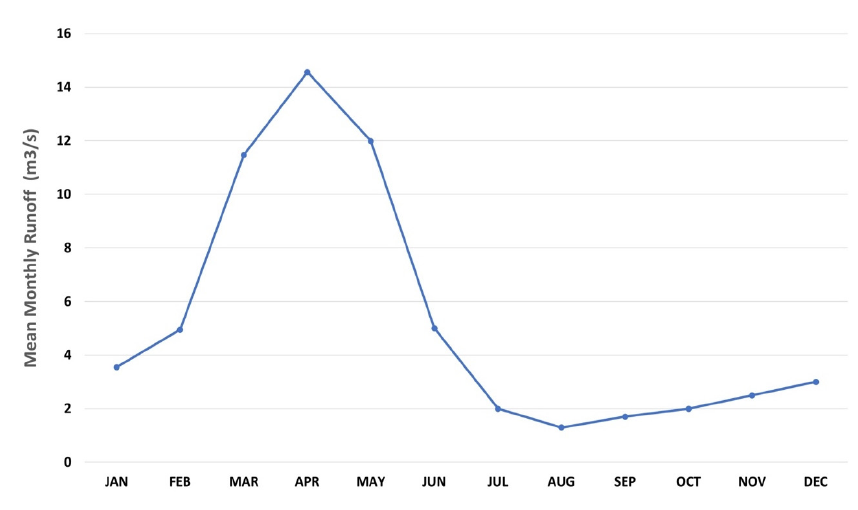
Figure 3. Monthly mean runoff in the Ourika watershed for the period of (1970–2014).